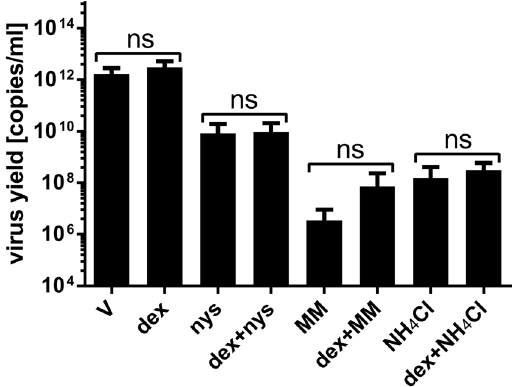
Figure 10. Macropinocytosis – stimulating agents re-direct virus trafficking in the cell. HCT-8 cells pre-treated with caveolin-1 and dynamin inhibitors were infected with HCoV-OC43 in presence or absence of dextran and viral yield was assessed by RT-qPCR 5 days p.i. nys − 10 μ g/ml nystatin; MM − 10 μ M MiTMAB; NH 4 Cl − 50 mM NH 4 Cl; V – non-treated HCoV-OC43 infected cells; dex – dextran-TMR. The data is presented as the mean of a triplicate for each sample ± SD. To determine the significance of differences between compared groups, Single-Factor Analysis of Variance (ANOVA) was applied. *** P values < 0.05 were considered significant; ns – not